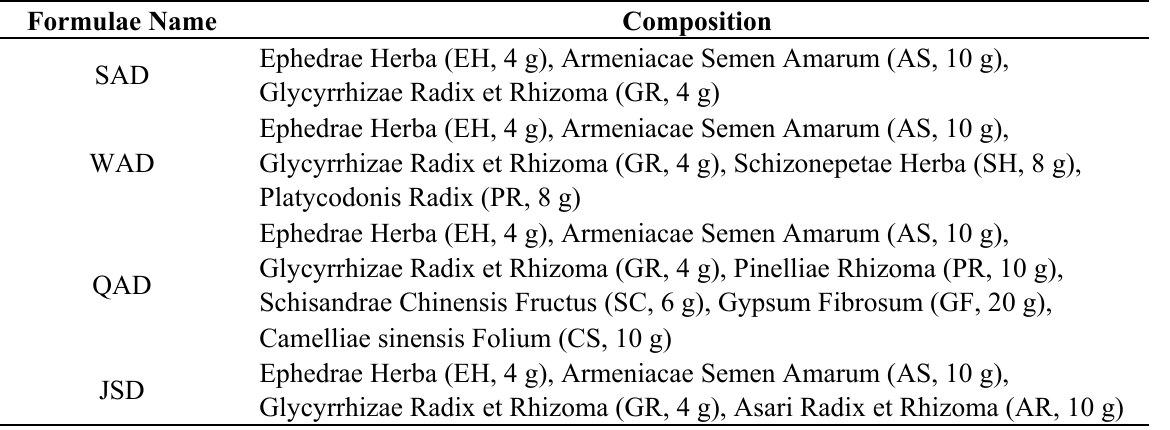
Table 1. The composition of San-ao Decoction and its series of